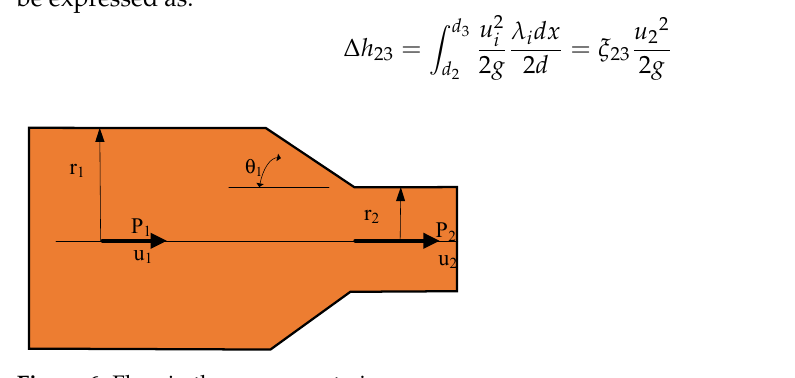
Figure 6. Flow in the convergent pipe In which, ξ 23 =